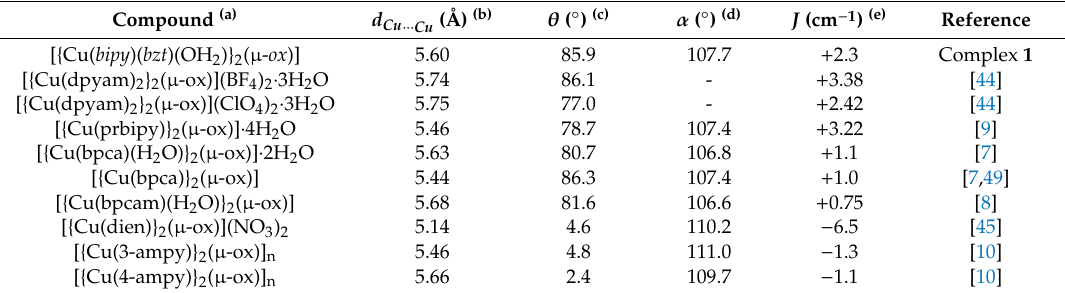
Table 3. Selected magnetostructural parameters for oxalate-bridged copper(II)